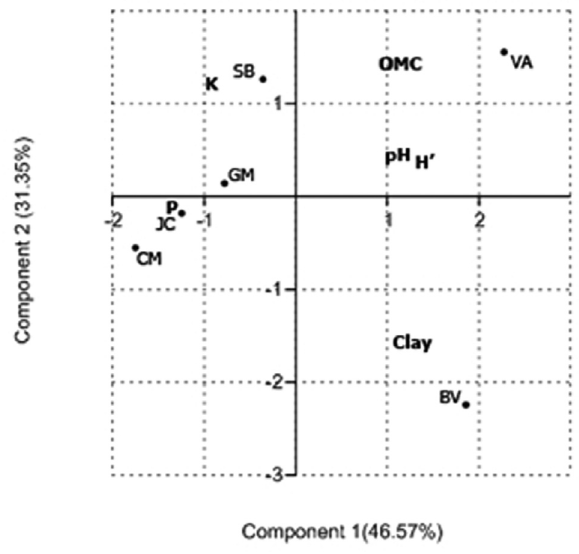
Figure 1 - Principal Component Analysis (PCA) of diversity indices in re- lation to soil abiotic properties [clay, organic matter content (OMC), pH, P, K,] determined from the six sampling sites (JC – Júlio de Castilhos, SB – São Borja, VA – Vacaria, CM – Campina das Missões, GM – Guarani dasMissões,andBV–BoaVistadoCadeado).Principalcomponent1and component 2 accounted for 46.57% and for 31.35% of the total variation,